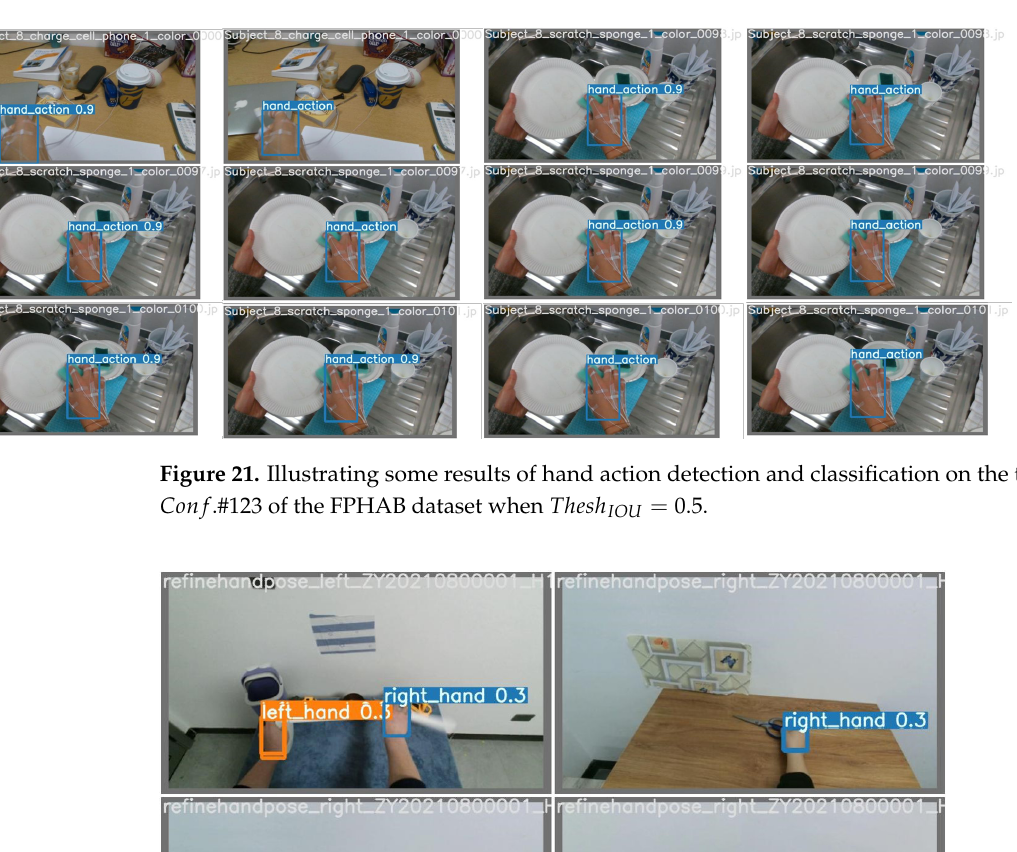
Figure 20. The confusion matrix of hand action classification on the testing set of Conf .#123 of the FPHAB dataset when Thesh IOU = 0.5.